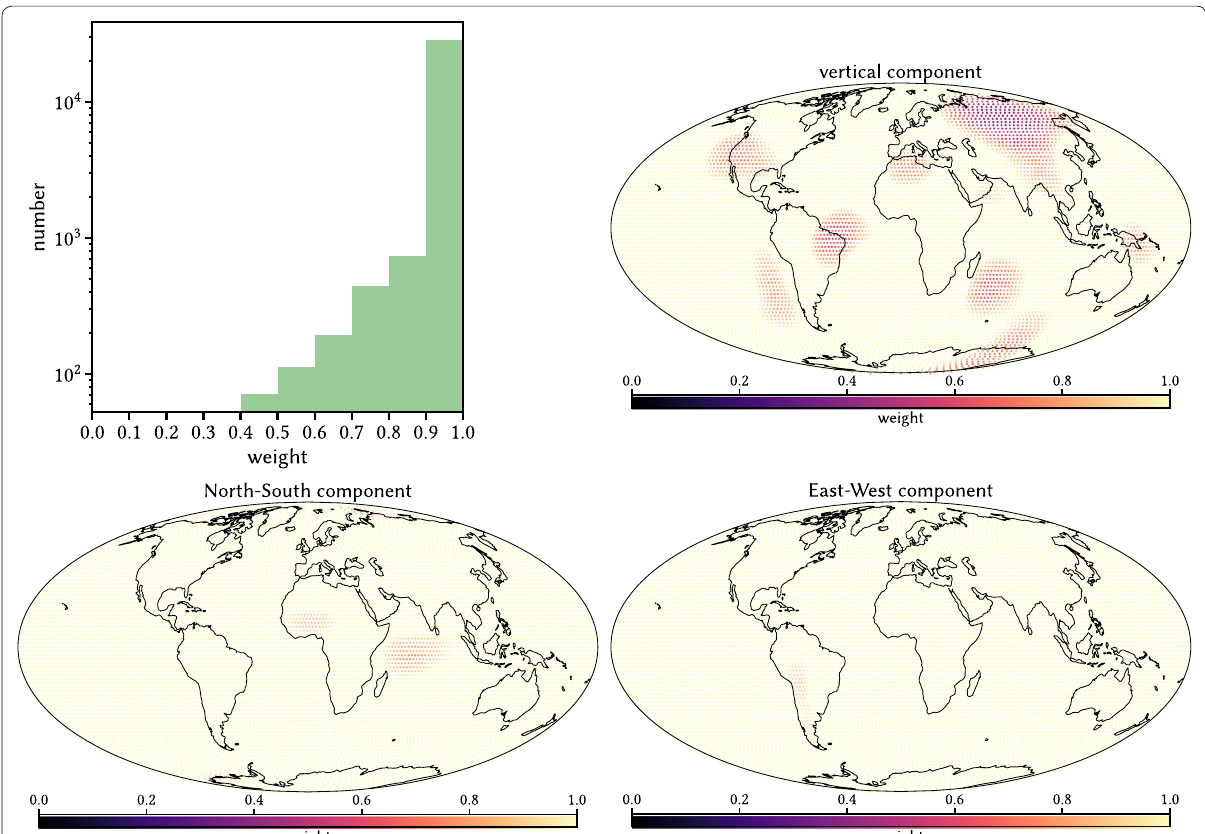
Fig. 8 Huber weights attributed to IPGP’s candidate. Top left: their distribution for the three components of the secular variation taken together (note that the y -scale is logarithmic). Top right: their spatial distribution for the vertical component of the secular variation. Bottom left: same for the North–South component. Bottom right: same for the East–West component. Mollweide projection for the three